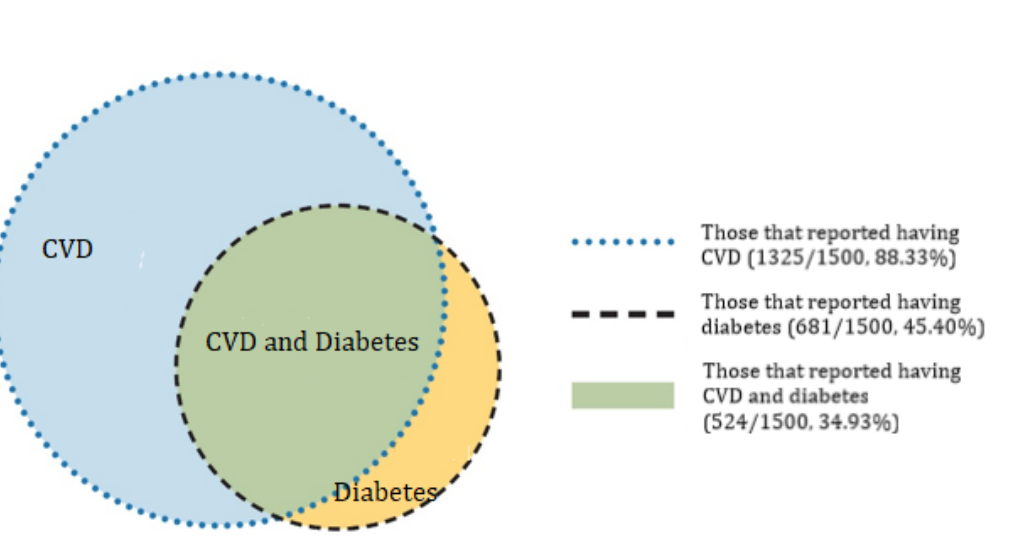
Figure 1. Sample composition and subsamples. CVD: cardiovascular